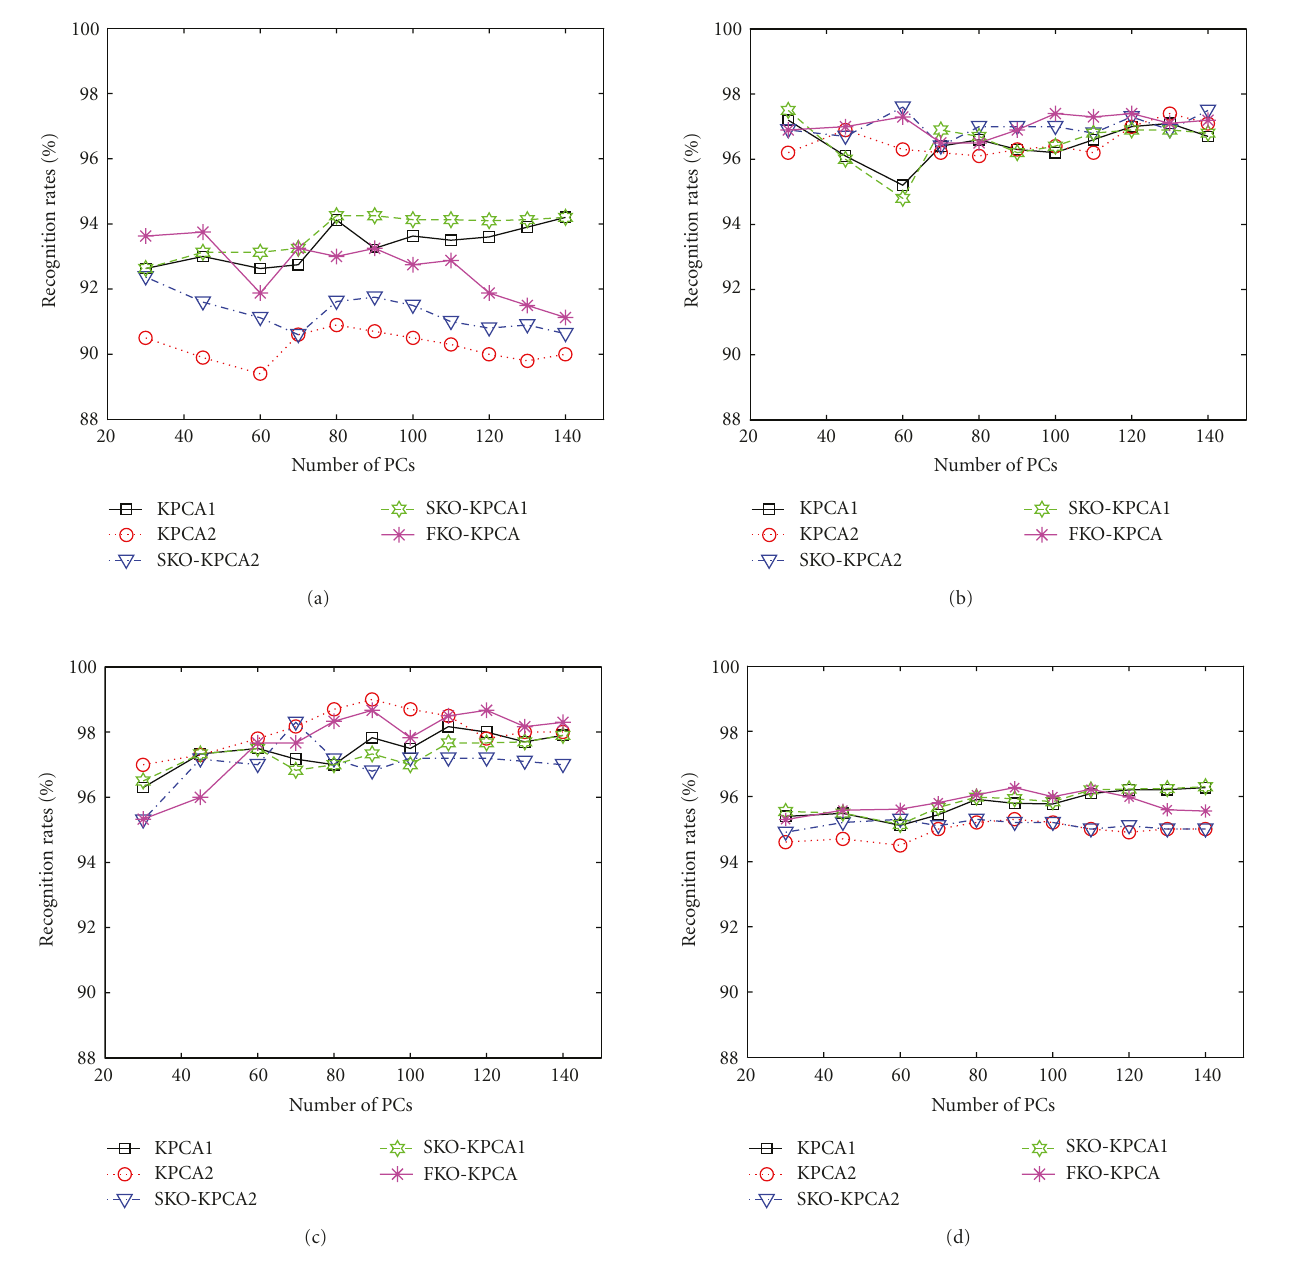
Figure 5: Recognition rates on the measured radar HRRP data versus number of principle components in three experiments. (a) An-26 (b) Cessna (c) Yark-42 (d) average recognition